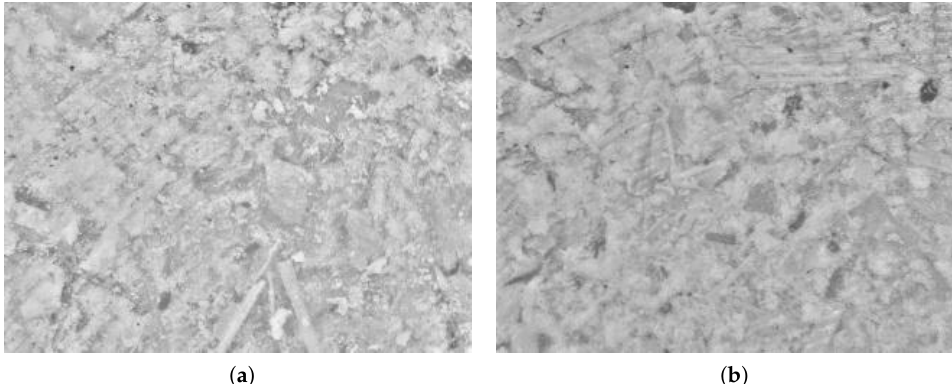
Figure 11. Example images from Figure 10 after conversion to grayscale, ( a )—luminance of the image from Figure 10b, ( b )—luminance of the image from Figure